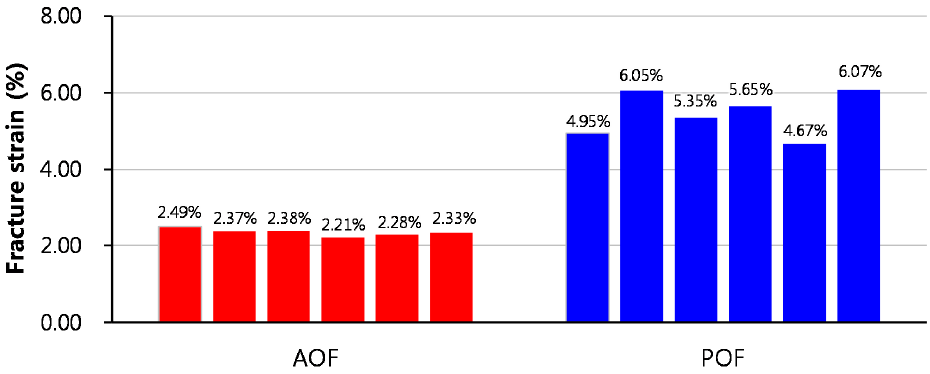
Figure 5. Fracture strains of optical fiber samples.